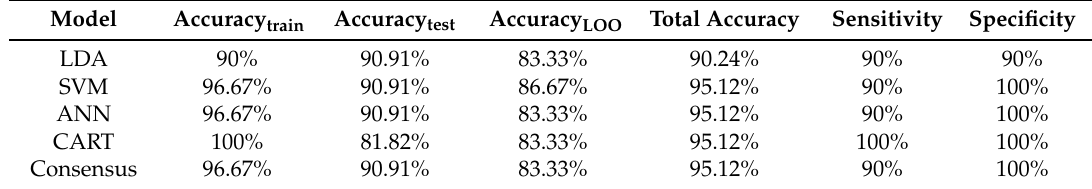
Table 4. The classification performance of four different modeling